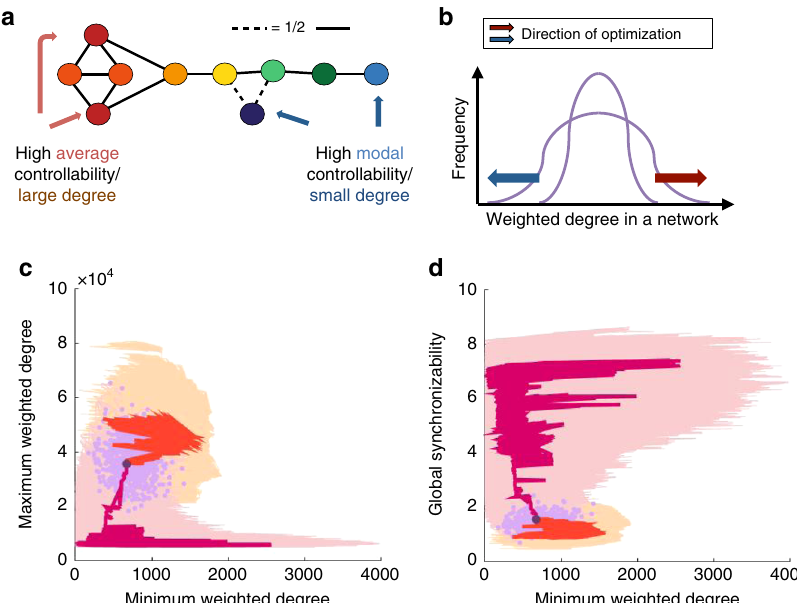
Fig. 6 Speci fi city of controllability vs. degree. a As average (modal) controllability of each node is closely tied to high (low) weighted degree of that node 10 , we repeat our optimization for maximum and minimum weighted degree in the network. b While the edge weight distribution of the network remains the same, edge swaps can alter the total degree of each node to increase the minimum (blue arrow) or maximum (red arrow) degree of the nodes. c , d The maximum and minimum weighted degree of each subject ’ s brain network are plotted as purple dots c and similarly for minimum weighted degree and synchronizability d — we see little structure or discernible relationship between individuals. We also plot representative optimization trajectories for each subject in the forward direction (yellow) in the cross section of increasing maximum weighted degree and decreasing minimum weighted degree c and decreasing minimum weighted degree and synchronizabililty d ; as well as trajectories in the opposite direction (pink). The trajectory for a single representative individual is highlighted, for both forward (red) and backward (dark red) directions. We observe that this example trajectory takes a meandering path through the plane, displaying little